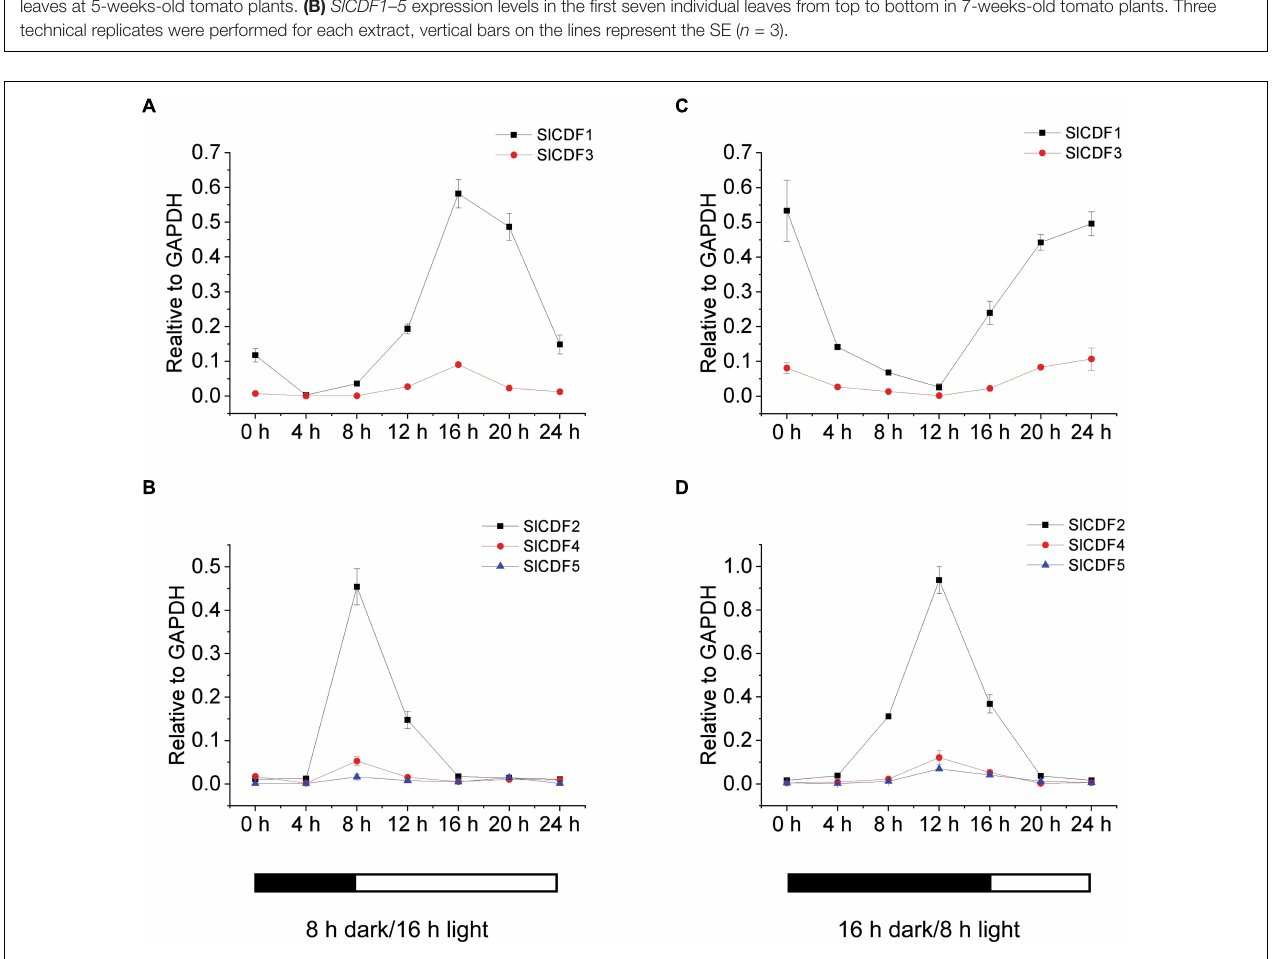
FIGURE 3 | Transcription analyses of tomato SlCDF1–5 in response to different photoperiods. Expression of SlCDF1–5 was analyzed by qRT-PCR in 4-weeks-old tomato plants grown under a diurnal cycle of 16 h light/8 h dark (A,C) or 8 h light/16 h dark (B,D) . White and black bars along the horizontal axis represent light and dark periods, respectively. Three technical replicates were performed for each extract, vertical bars on the lines represent the SE ( n = 3).